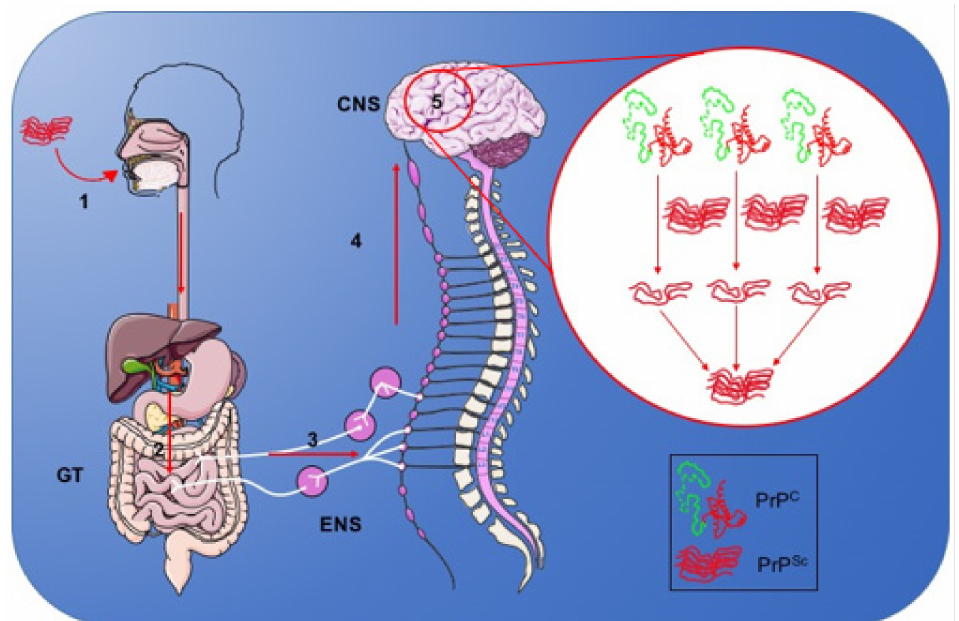
Figure 2. Gut–brain connection in prion infection. In the oral/intragastric route (1) of infection, PrP Sc crosses the gastroin (2), migrates and accumulates in the lymphoid tissues, and infects the enteric nervous system (ENS) (3), propagating to the central nervous system (4). In the brain, PrC Sc interacts with PrP C , and, acting as a template, converts it to the pathogenic conformation (5). Conversion follows an autocatalytic replication, forming many copies of PrP Sc that aggregate (5), triggering cell